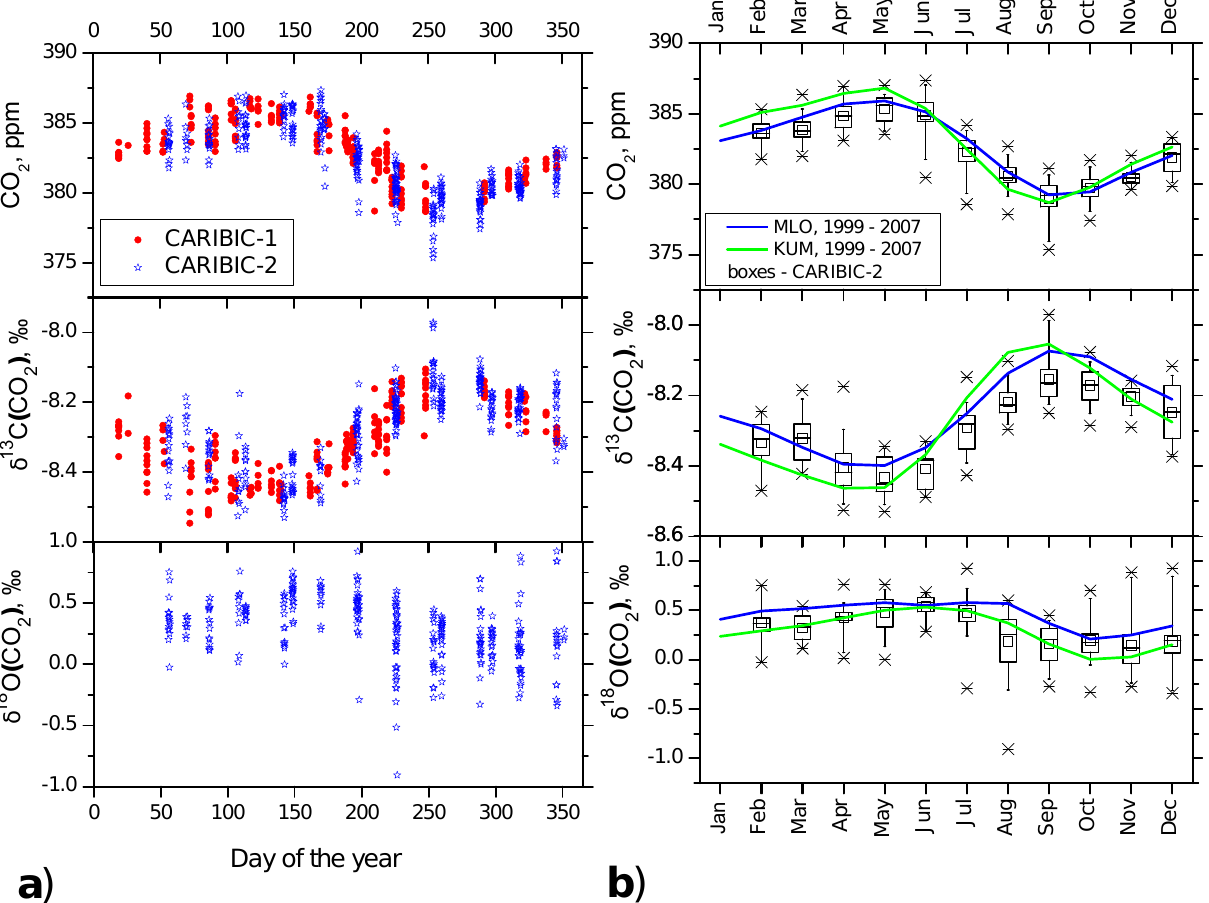
Fig. 14. (a) Seasonality for tropospheric air masses detected by CO 2 isotopes; all flights, latitudes > 14 ◦ N. Data de-trended to 1 Jan- uary 2007. (b) The 1999 to 2007 averaged monthly mean data for KUM and MLO (de-trended data) and tropospheric CARIBIC-2 data (box-plots). Plumes evidenced by very high water and high CO are filtered out (H 2 O > 2000ppm and CO > 125ppb). Box ranges are at 25, 50 and 75%, Whiskers are at 5 and 95%, square corresponds to the Median and crosses indicate Min and Max values.